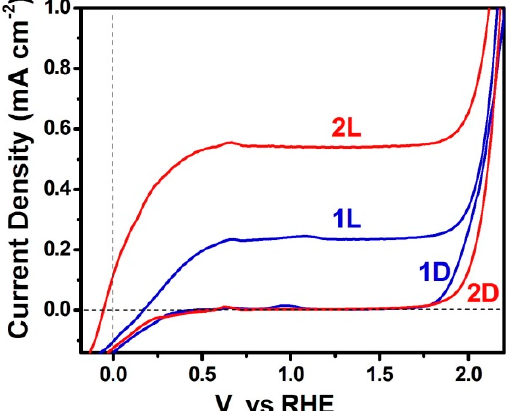
Figure 5. Current density-Voltage curves obtained with a PFC functioning in the presence of oxygen. The aqueous electrolyte always contained 0.5 mol·L − 1 NaOH without (curve 1) or with (curve 2) 5 v % ethanol. L signifies irradiation (Light) and D dark. In both cases photoanode carried bare np-TiO 2 film. The curves were traced in a 3-electrode configuration using Ag/AgCl as reference electrode. The curves are presented vs. RHE by adding 0.97 V to the recorded